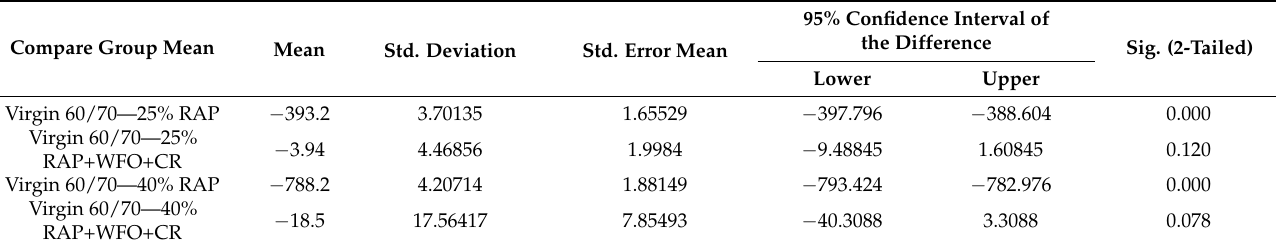
Table 8. Comparison of significant difference of group means for the viscosity result at 135 ◦ C. Compare Group Mean Mean Std. Deviation Std. Error Mean